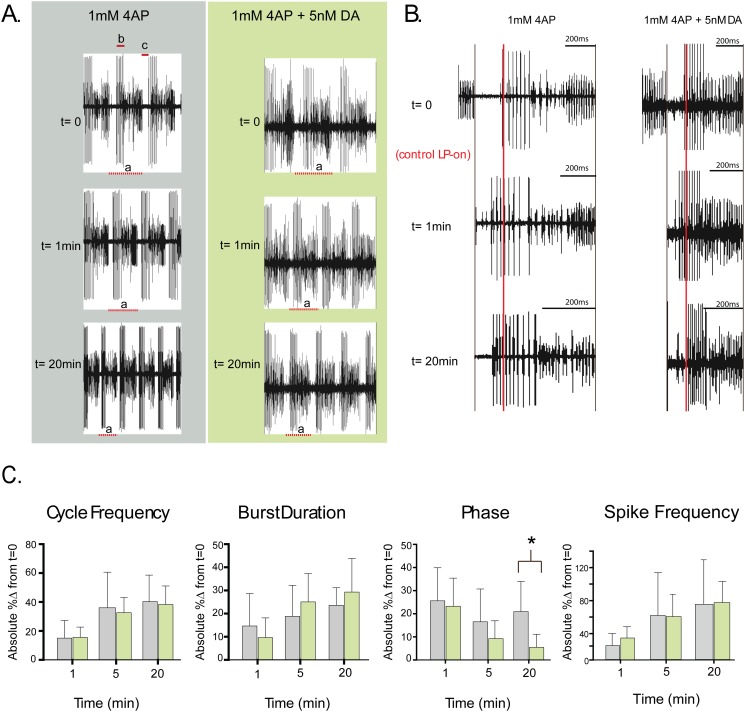
Tonic nM DA stabilizes the timing of LP activity over the short term.
(A) Pyloric output is altered by 1mM 4AP. Representative experiments showing the motor output at three time points for a preparation continuously superfused with 1mM 4AP (blue) or 1mM 4AP + 5nM DA (green) beginning at t = 0. Each trace from one preparation represents the same length of time. Cycle period is measured as the last spike in a PD burst to the last spike in the subsequent PD burst and is indicated by “a” in each trace. LP burst duration is indicated by “b”, and LP-on delay, which is the time between the last PD spike and the first LP spike, is indicated by “c”. Intraburst spike frequency is the number of spikes per burst divided by burst duration. (B) The timing of LP activity is stabilized by 5nM DA. In order to visually compare the timing of LP activity at t = 0,1min and 20min, we performed the following manipulations on each the two sets of traces shown in panel A. First, we aligned one cycle period for each of the three time points (dashed lines below traces) by the last spike in the preceding PD burst. Second, the horizontal axes of the 1min and 20min traces were scaled to match the length of the t = 0 trace. The red line marks the point in the cycle when the first LP spike occurs for the t = 0 trace. Note that in both preparations a 1min 1mM 4AP bath application caused LP activity to occur earlier in the cycle. LP activity remained phase advanced only in the absence of 5nM DA. (C) 5nM DA preserves the timing of LP activity phase but not cycle frequency, or LP burst duration and intraburst spike frequency. The absolute value of the percent change in cycle period, LP burst duration, LP-on phase (c÷a) and LP intraburst spike frequency is plotted (mean+stdev) at 1min,5min and 20min for preparations superfused with 1mM 4AP (blue) or 1mM 4AP+5nM DA (green). Asterisks indicate significant differences between treatment groups as determined using 2-way ANOVAs with post-hoc Bonferroni’s multiple comparisons tests. Cycle period: Time, F(2,38) = 47.62, p<0.0001; Treatment, F(1,19) = 0.1388, p = 0.7136; Interaction F(2,38) = 0.3760, p = 0.6891. LP burst duration: Time, F(2,38) = 9.257, p = 0.0005; Treatment, F(1,19) = 0.4796, p = 0.4970; Interaction, F(2,38) = 1.876, p = 0.1672. LP phase: Time, F(2,36) = 10.46, p = 0. 0003; Treatment, F(1,18) = 4.659, p = 0.0446; interaction F(2,36) = 2.645, p = 0.0848. LP intraburst spike frequency: Time, F(2,36) = 51.99, p<0.0001; Treatment, F(1,18) = 1.291, p = 0.2708; Interaction F(2,36) = 1.387, p = 0.2627. Note that absolute values were chosen because in some cases a given parameter could increase or decrease over time according to the preparation, so averaging did not reflect the degree of change that was observed.